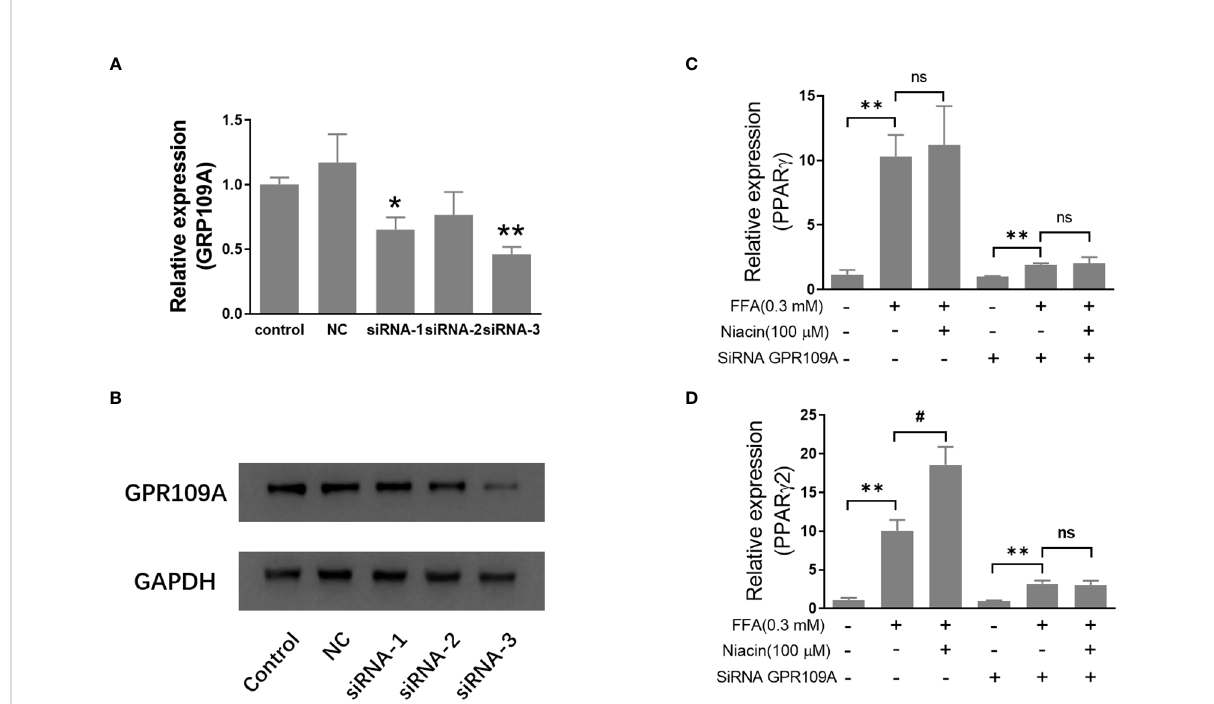
FIGURE 5 Inhibition of GRR109A mRNA expression by siRNA attenuates niacin induced PPAR g 2 mRNA expression in INS-1 cells. INS ‐ 1 cells were transfected with Opti ‐ MEM (Control), nonspeci fi c siRNA (NC), or three different siRNA (siRNA ‐ 1, siRNA ‐ 2, siRNA ‐ 3) targeting the GPR109A for 12 hours, then cells were treated with 100 m M niacin in the absence or presence of 0.3 mM FFA for 48 hours. (A, C, D) Total RNA was extracted for quantitative PCR. (B) Total protein was extracted for western blot analyse. Data were from three independent experiments and represent mean ± SD. n=3, *P < 0.05 and **P < 0.01 compared to respective control group; # P < 0.05 compared to the siRNA control plus FFA group. NS means not signi fi cant